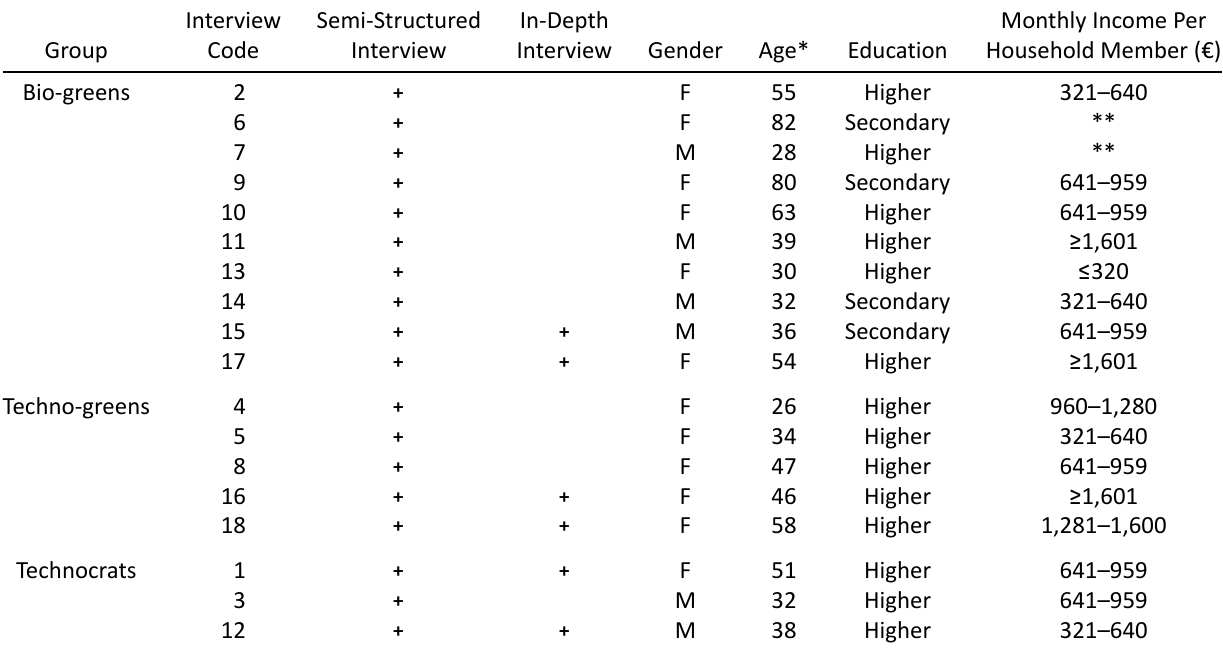
Table 1. Socio‐demographic data of